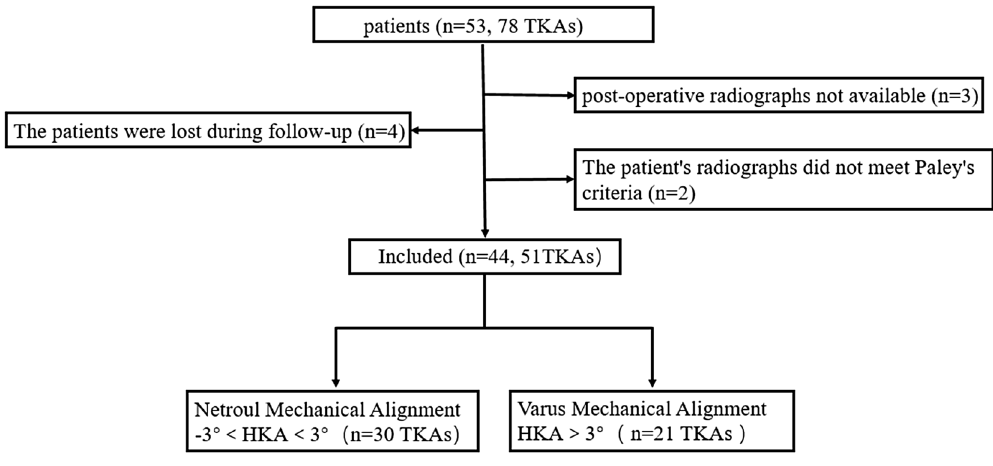
Figure 1. Flowchart of patients included in the